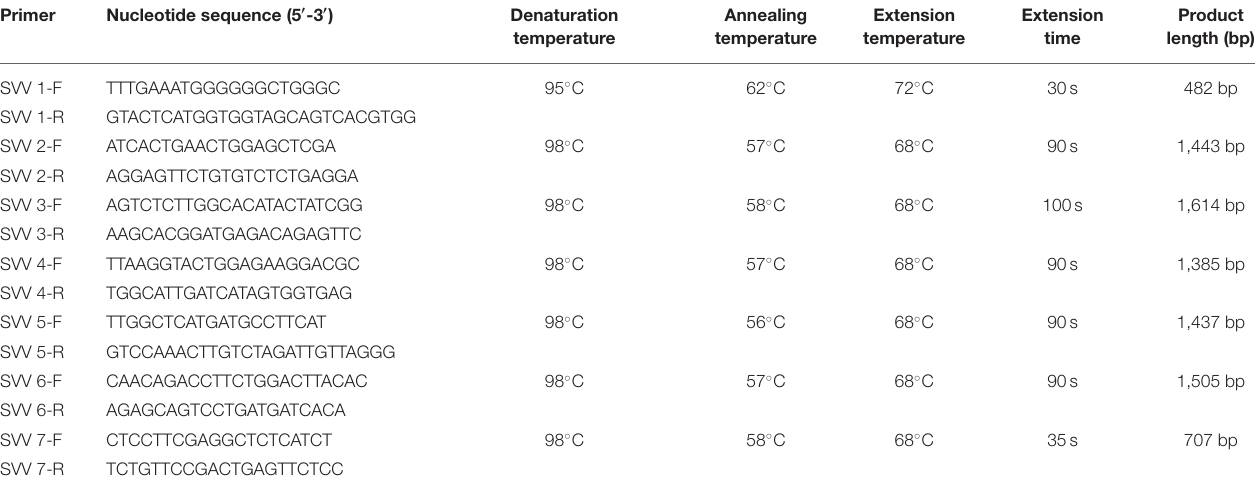
TABLE 1 | Primers used for genome amplification of SVV.